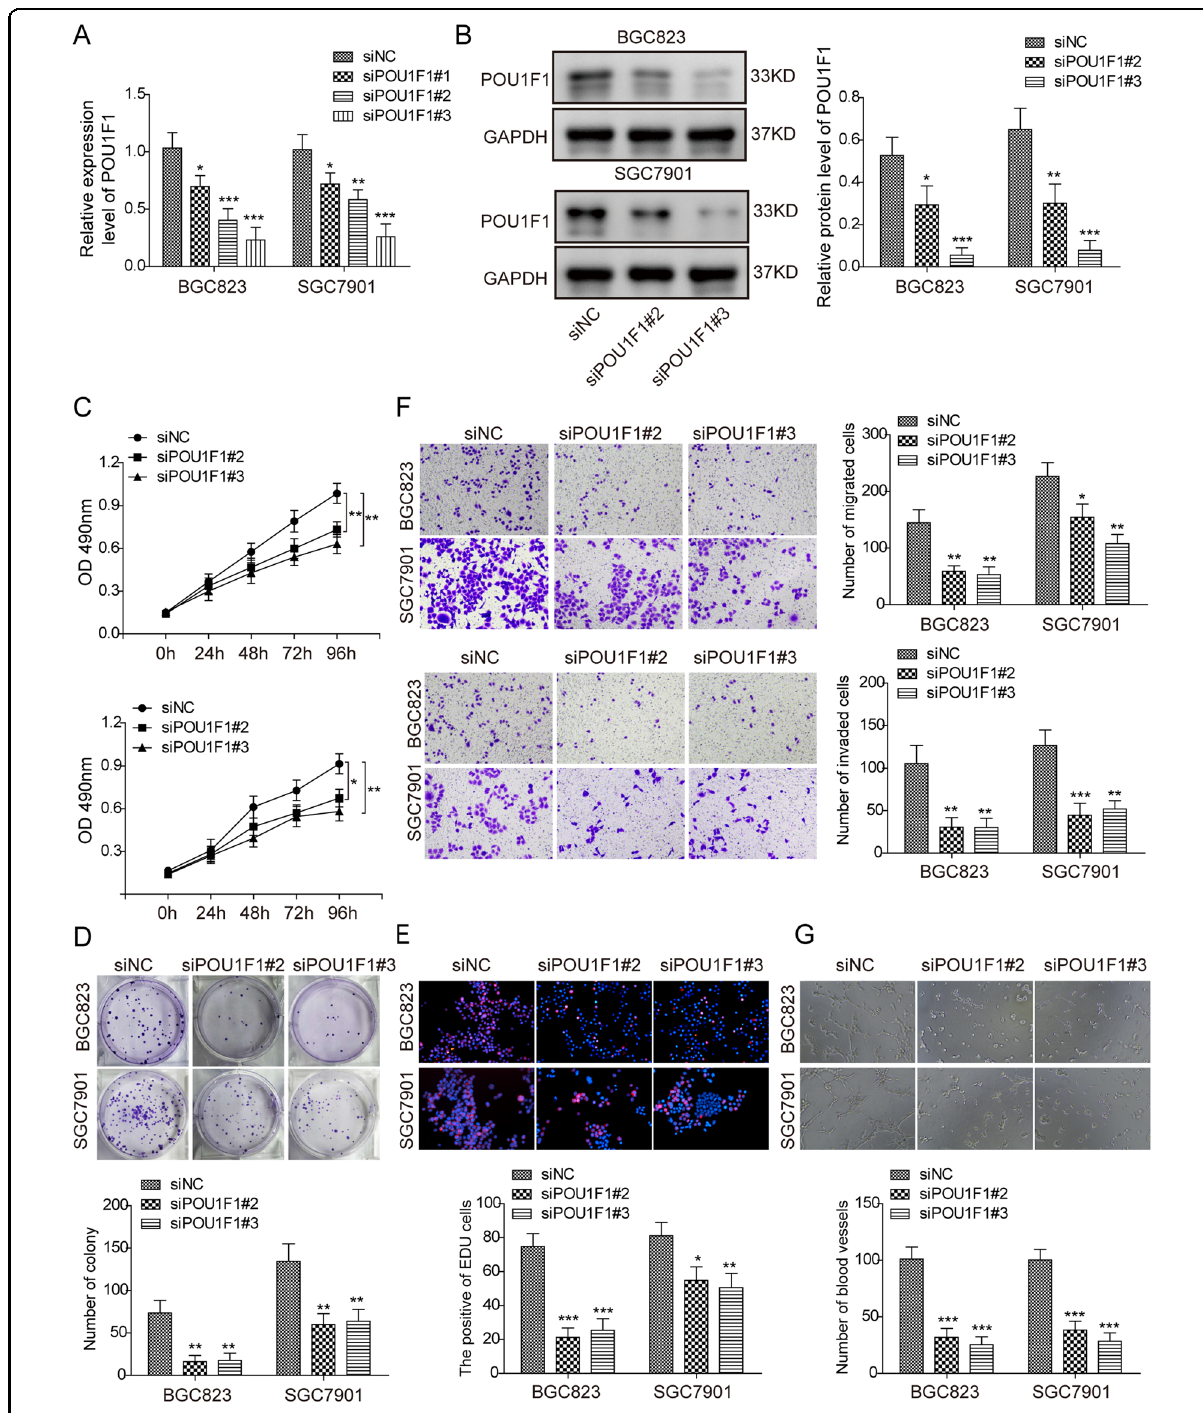
Fig. 2 Knockdown of POU1F1 inhibits cell proliferation, migration, invasion, and angiogenesis in GC cells. A The mRNA level of POU1F1 was determined by qRT-PCR analysis. B The protein level of POU1F1 was determined by western blot. GAPDH served as a loading control. C Cell proliferation was monitored by CCK-8 assay. D Colony forming ability was assessed by colony formation assay. E DNA synthesis and cell proliferation was monitored by EdU incorporation assay. Red, EdU; Blue, DAPI. F The capacity of cell migration and invasion were assessed by transwell system. G In vitro angiogenesis was monitored by tube formation assay. Data were representative images or were expressed as the mean ± SD of n = 3 experiments. * P < 0.05, ** P < 0.01, *** P <